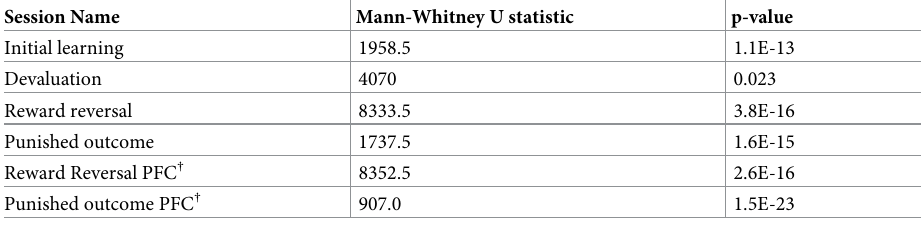
Table 2. Discrepancy between goal-directed learning and